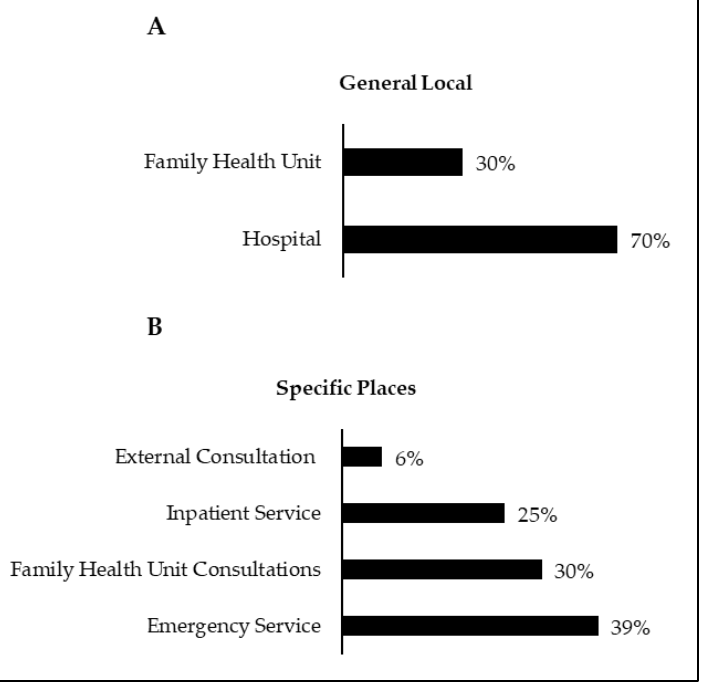
Figure 1. General locations for applying the questionnaire ( A ); specific places of application of the questionnaire ( B ).